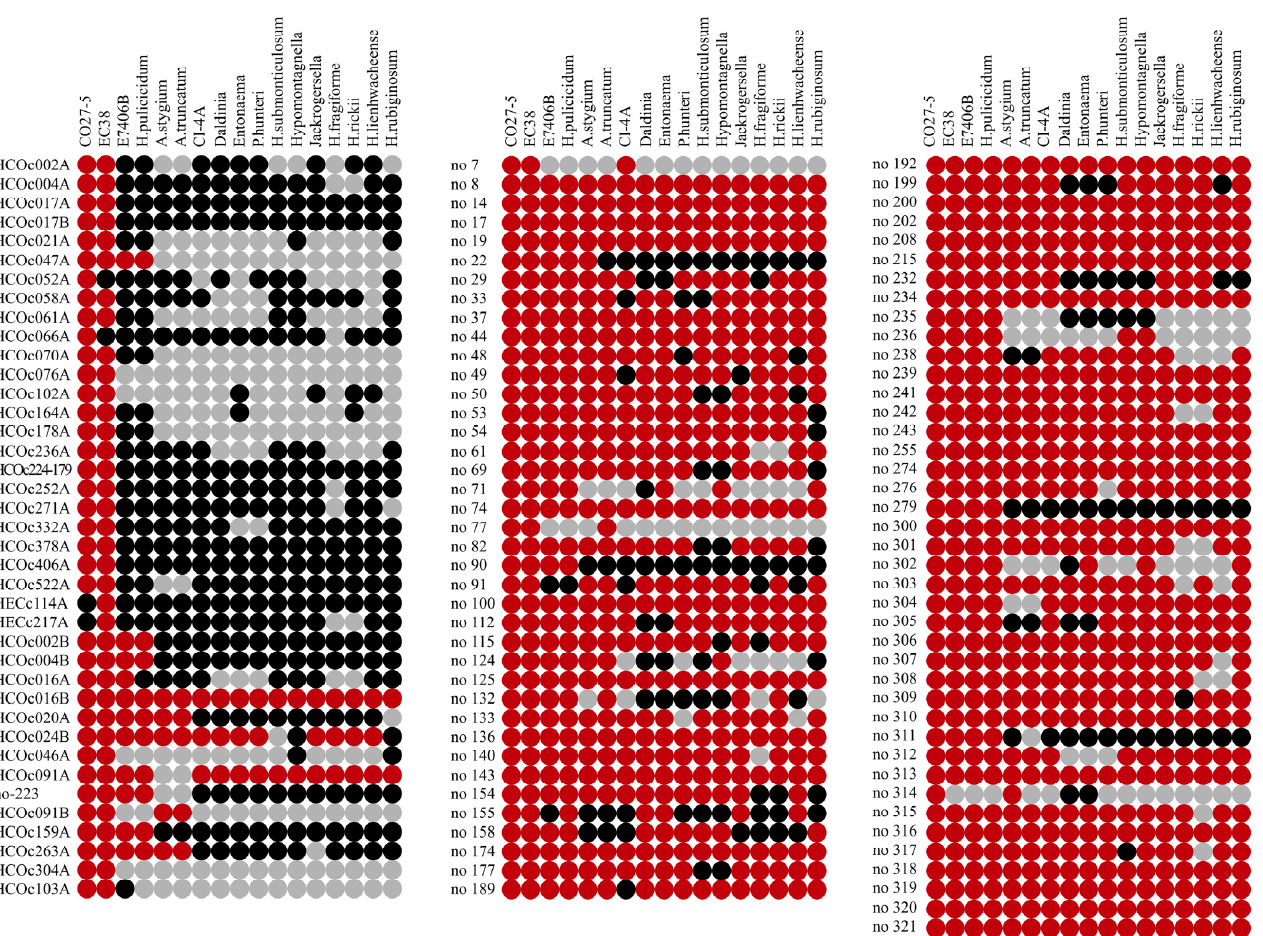
Figure 3. Occurrence of 117 orthologue [D1,2] stwintrons at the same gene position in 17 taxa of Hypoxylaceae. Four genomes in the Daldinia genus— D. eschscholzii , Daldina sp. EC12, D. childiae and D. concentrica —were considered as one taxon. The red circles indicate that the stwintron position confirmed in Hypoxylon sp. CO27-5 is also occupied by a [D1,2] stwintron in the intron–exon structure of the orthologue gene in another species or strains of Hypoxylaceae. The black circles indicate that the CO27-5 stwintron position was not occupied in the orthologue gene in another species or strains. The grey circles indicate the absence of the orthologue gene in other species or strains. Twenty-four of the 25 full sister stwintrons (named as in [25]) exclusively occurred in the strongly related strains CO27-5 and/or EC38 with four sister stwintrons unique to either CO27-5 or EC38. For almost all of the 81 newly reported, uniquely occurring (UO) stwintrons, occupation of the stwintron position was not restricted to Hypoxylon sp. CO27-5 or EC38. Note that for stwintron number no-274, the [D1,2]